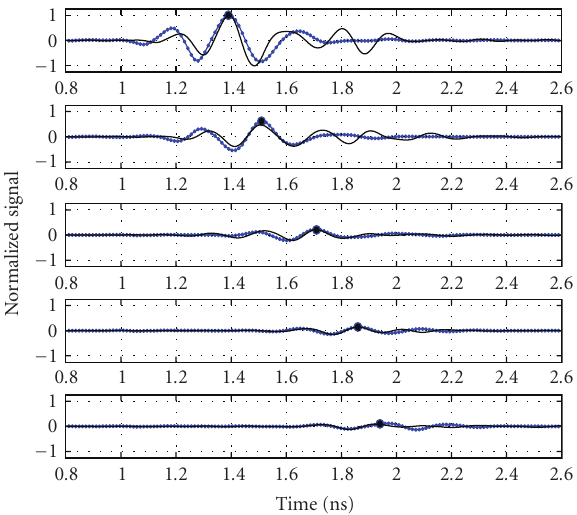
Figure 6: Subset of backscattered signals after early-time response removal (from top to bottom) for antenna #7 (closest to the tumor), #10, #13, #16, #19 (farthest from the tumor). Solid line: experiment, ( • ): simulations. Black bullet marks expected signal time-of-arrival for each